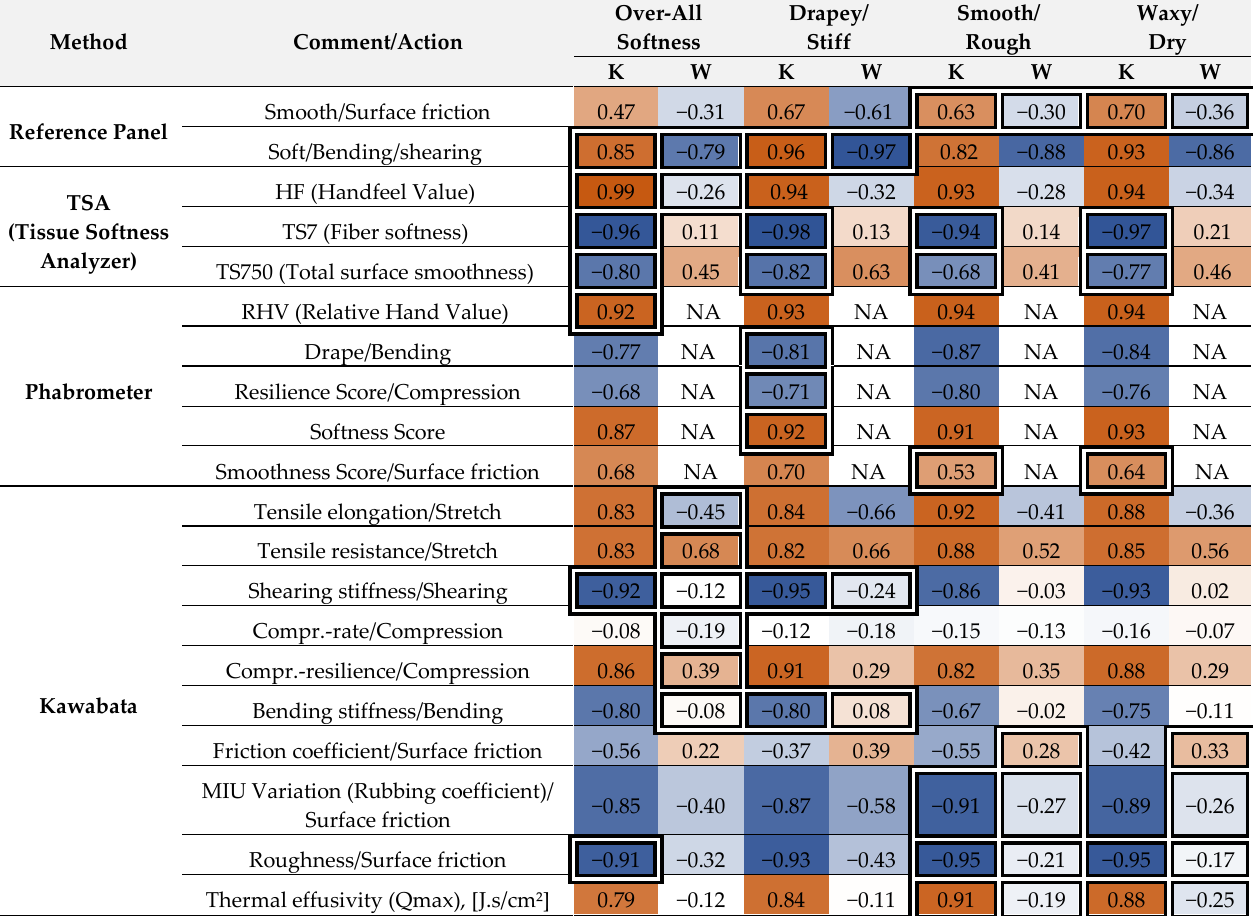
Table 4. Pearson correlation factors between human and instrumental hand-feel related parameters.